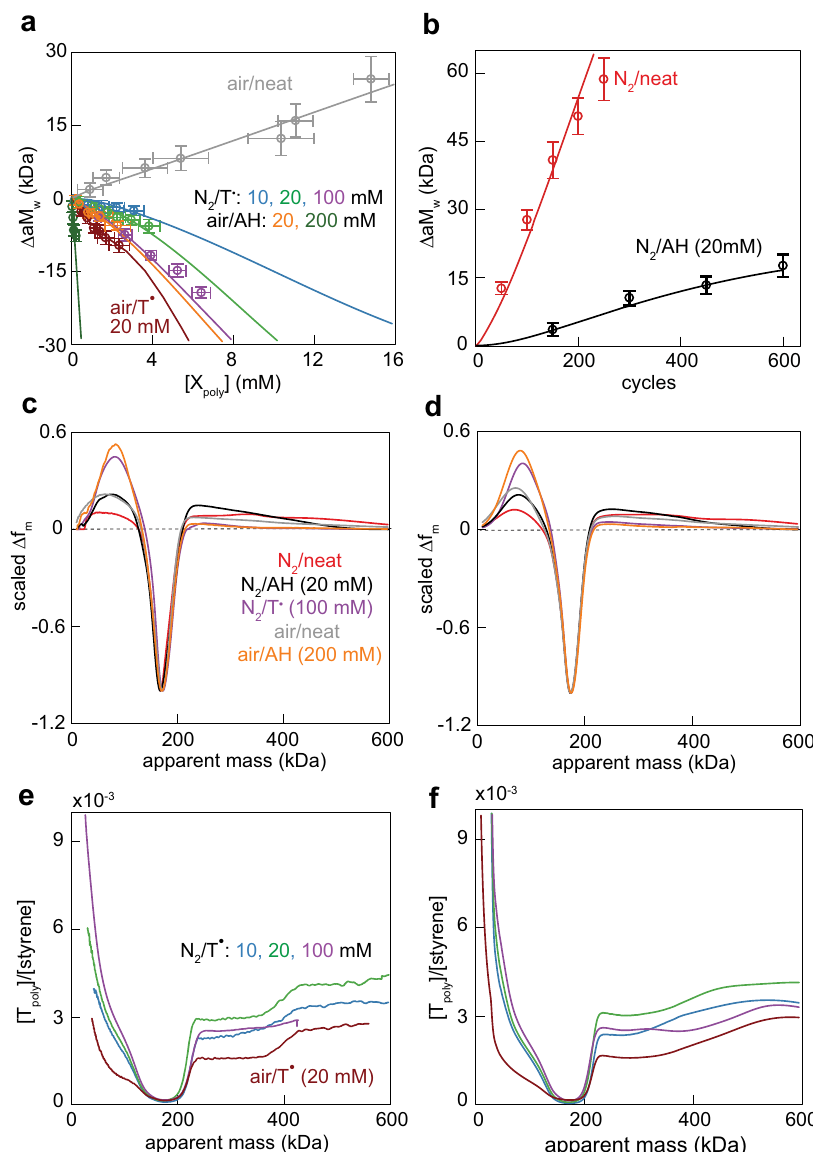
Fig. 4 The proposed remodeling mechanism reproduces all experimental observations. a Experimental (dots) and simulated (lines) correlations between the concentration of polymer-bound T or OOH moieties, [X poly ], and change in a M w ; b Experimental (dots) and simulated (lines) increase in a M w as a function of the number of shearing cycles for the conditions that do not generate polymer-bound T or OOH moieties. Error bars de fi ne 2 σ con fi dence intervals. Representative experimental ( c ) and simulated ( d ) differential aMMDs at the end of each shearing experiment. Each differential aMMD was scaled to the same minimum value to facilitate comparisons. See Supplementary Figs. 25 and 23 for all simulated apparent and true MMDs. Distribution of polymer-bound T moiety per styrene, [T poly ]/[styrene] as a function of the apparent chain mass at the end of each listed experiment ( e ), and the corresponding simulated distribution ( f ). Because larger chains contain more styrene moieties per chain, the approximately constant [T poly ]/[styrene] vs. mass correlations at >200 kDa correspond to increasing numbers of T moieties per average chain: for example, an average 400 kDa chain with [T poly ]/ [styrene] = 3 × 10 − 3 carries 4.7 ± 0.4 T moieties (Supplementary Fig.